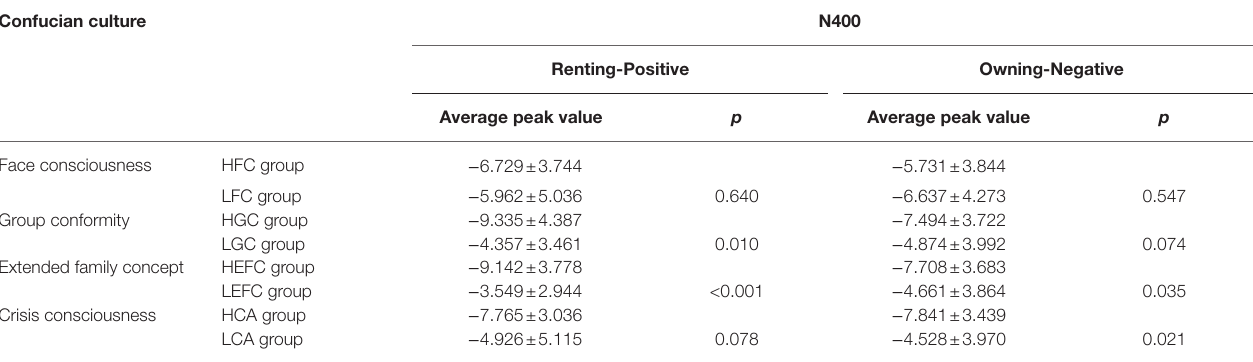
TABLE 4 | The average peak value and SE of N400 for Confucian culture under the four sub-dimensions. Confucian